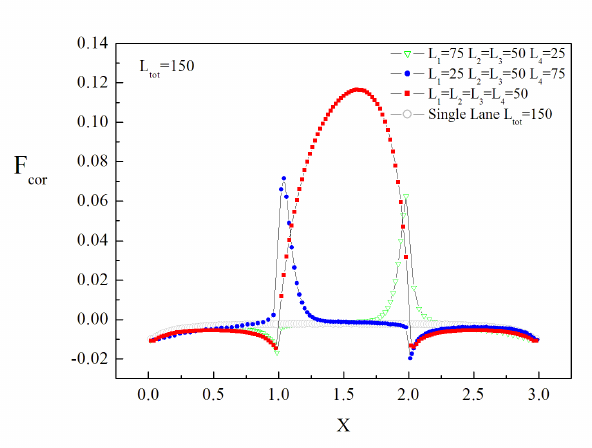
Simulation results: Nearest-neighbor correlations F corr , in the ( MC, CL, MC ) phase state of the system, as a function of the scaled distance x = i/L k , for different positions of the double-chain